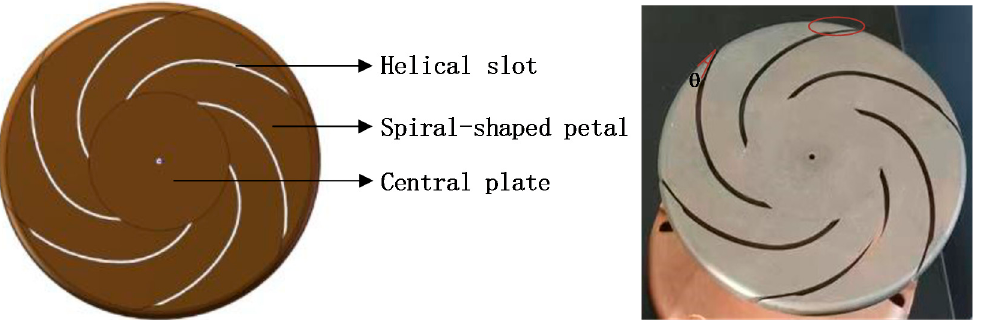
Figure 3. Structural design of the rotary electrode in the developed experimental PJT-GS prototype ( Left ) and the corresponding prototype of the electrode ( right ).